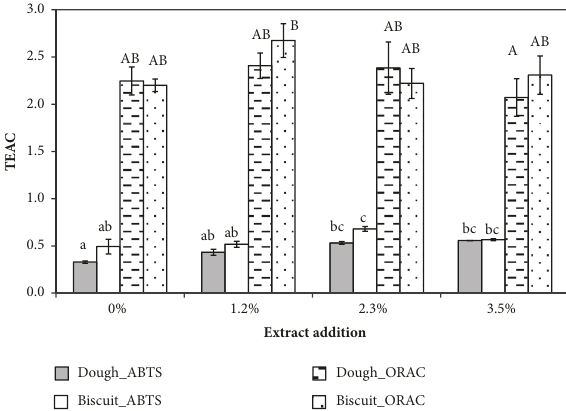
Figure 2: Influence of grape skin extract addition at different levels (0, 1.2, 2.3, and 3.5% on dough weight) on the specific antioxidant capacity (TEAC’ = 𝜇 mol Trolox (cid:2) / g dm ) of dough and biscuit, based on the ABTS assay or the ORAC assay. Different lowercase letters indicate means statistically different for the ABTS results, while uppercase letters indicate means statistically different for the ORAC results, according to ANOVA analysis and post hoc Tukey’s test (p < 0.01). Error bars indicate ± SD of mean values (n = 3).